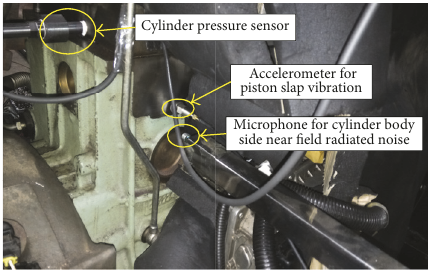
Figure 9: Specific arrangement of the measuring point.